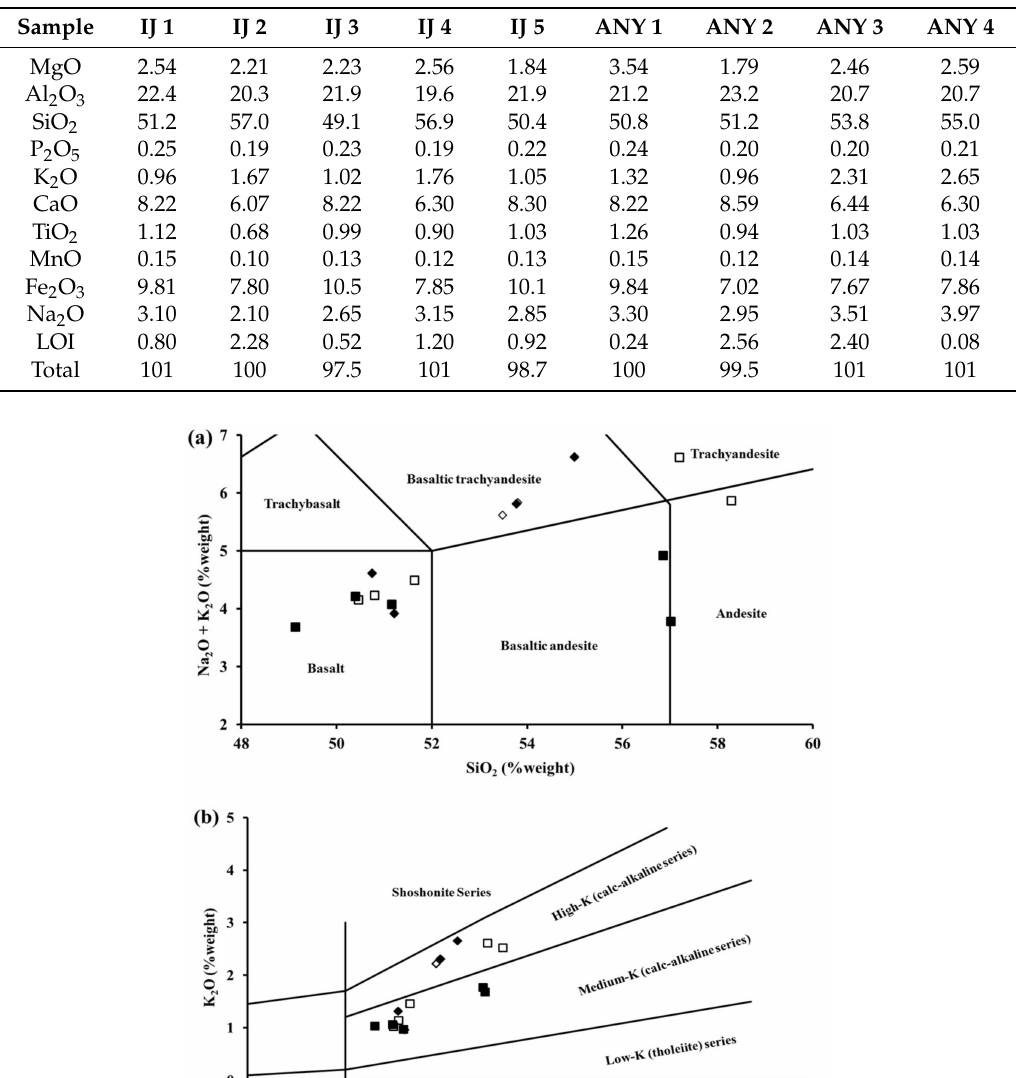
Table 1. Major elements (% weight) of all samples.